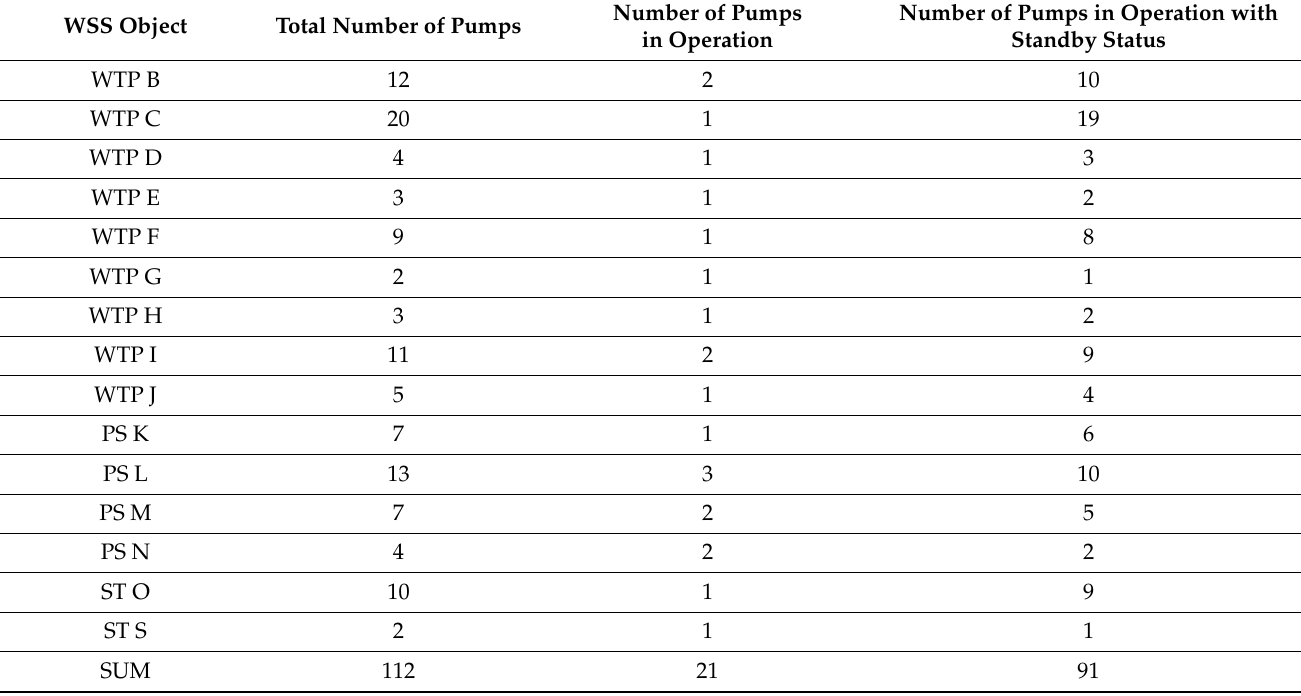
Table 1. Lists of pumping station equipment with